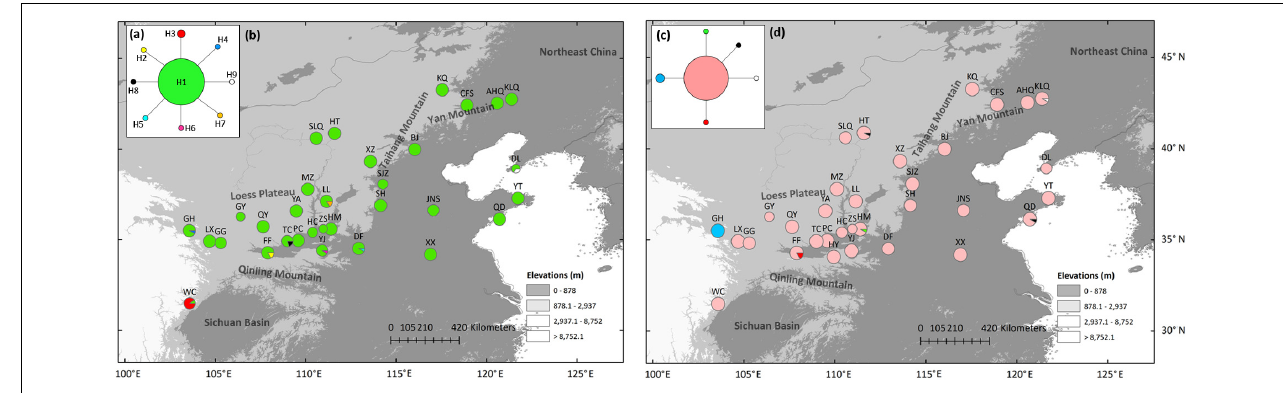
FIGURE 3 | Most parsimonious network (a,c) and geographic distribution (b,d) of Speranskia tuberculata haplotypes of low-copy nuclear genes of 38274 (a,b) and 6146 (c,d) , respectively.